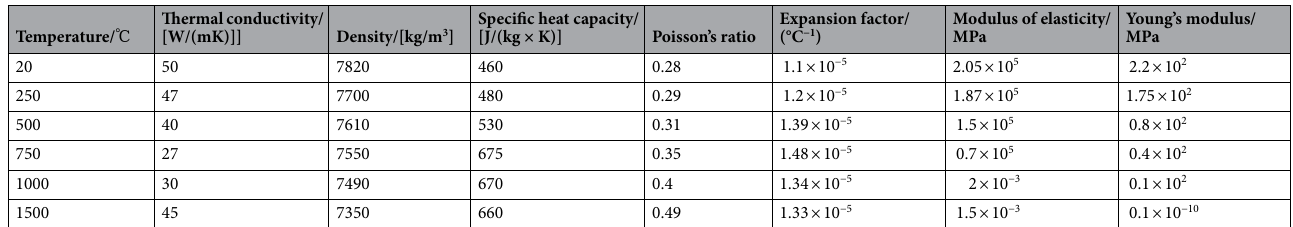
Table 1. Q345 steel performance parameters.